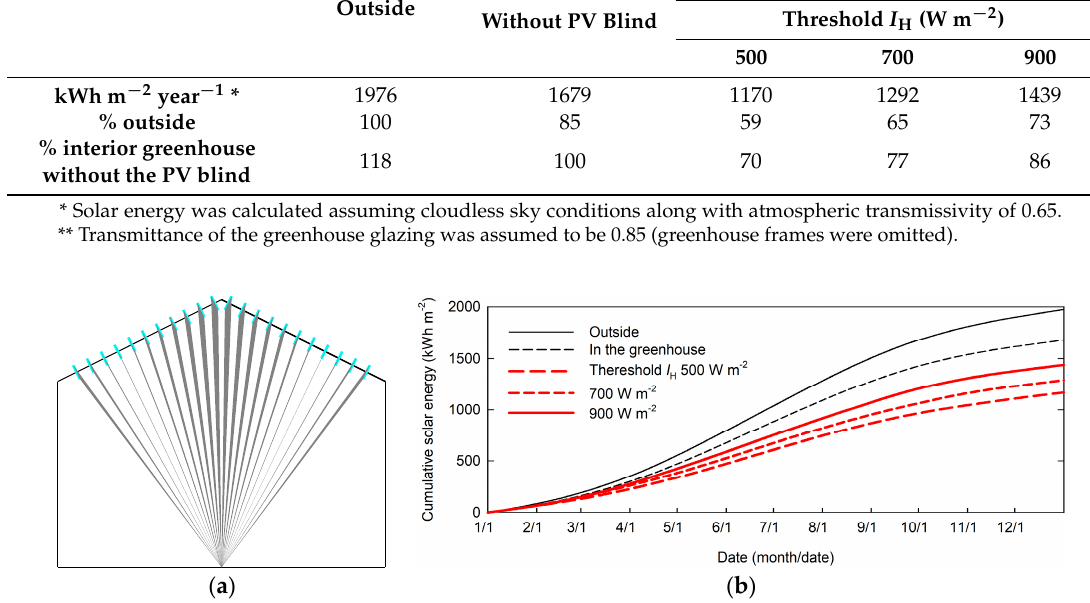
Table 5. Estimated annual solar energy in the north–south oriented greenhouse equipped with the PV blind entirely covering the roof with three threshold irradiance values for the PV blind operation. Inside the Greenhouse ** PV Blind Overlapped with Glazing Roof Outside Threshold I H (W m − 2 ) Without PV Blind